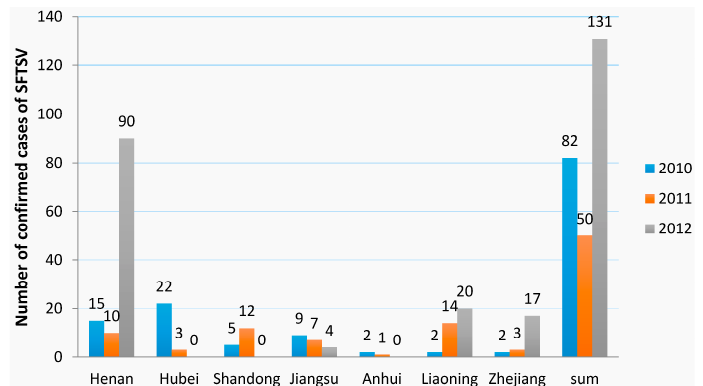
Figure 4. Regional distribution of the confirmed cases of SFTSV, 2010–2012. The statistics were